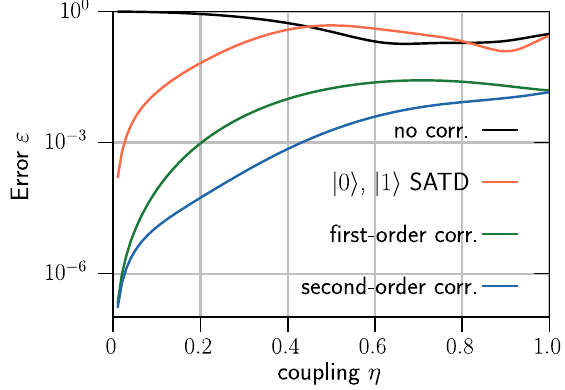
FIG. 8. Fidelity error for an attempted j 0 i → j 1 i state transfer in the MLZ model with two leakage levels [cf. Eq. (74)], as a function of the dimensionless coupling η . We have taken the couplings involving spurious levels to be the same as the coupling η between qubit levels, i.e., η η η η , and we have set 03 ¼ 12 ¼ 23 ¼ the energy offsets ω 2 ¼ ω 3 ¼ 0 . 1 . Different curves correspond to different possible corrections (as indicated in the figure). Without any correction, small errors are not possible for any choice of η ; in contrast, if one includes the Magnus corrections, errors less than 10 − 3 are possible for a wide range of η